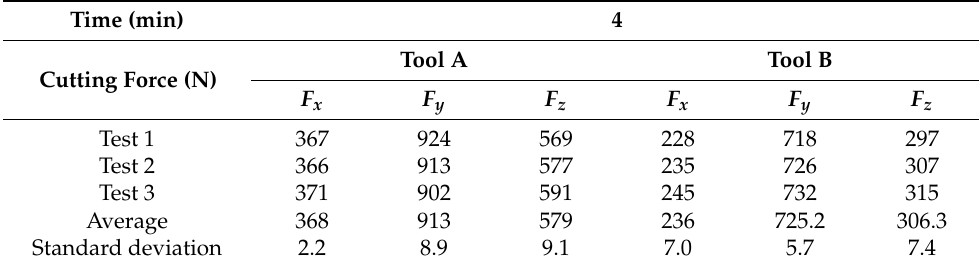
Table 5. Partial data and analysis of cutting force.